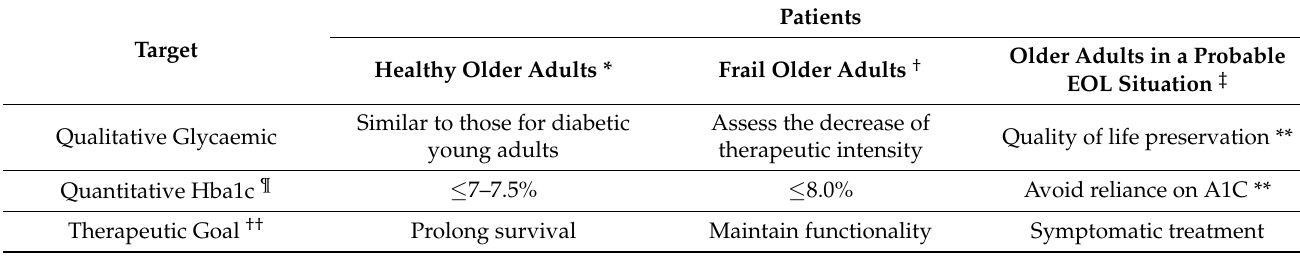
Table 1. Type 2 Diabetes Mellitus (T2DM) therapeutic goals considering patient